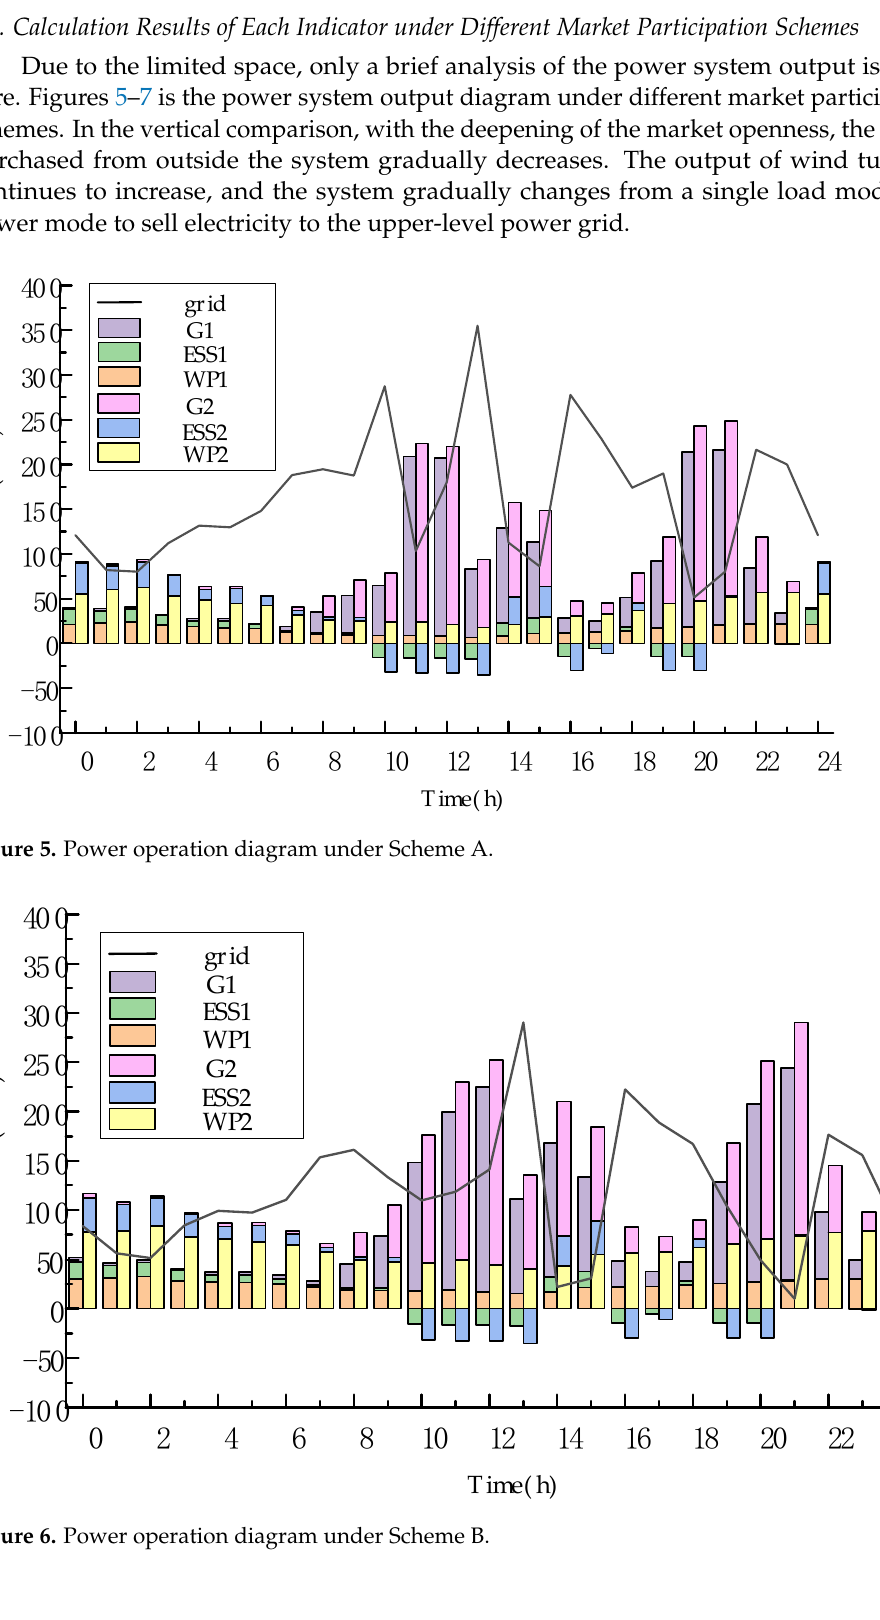
Figure 7. Power operation diagram under Scheme C. According to the calculation method of each indicator in the low-carbon capability evaluation system (Formulas (1)–(15)), the indicators of the low-carbon situation and mar- ket structure are calculated, respectively, and the calculation results are shown in Tables 3 and 4.